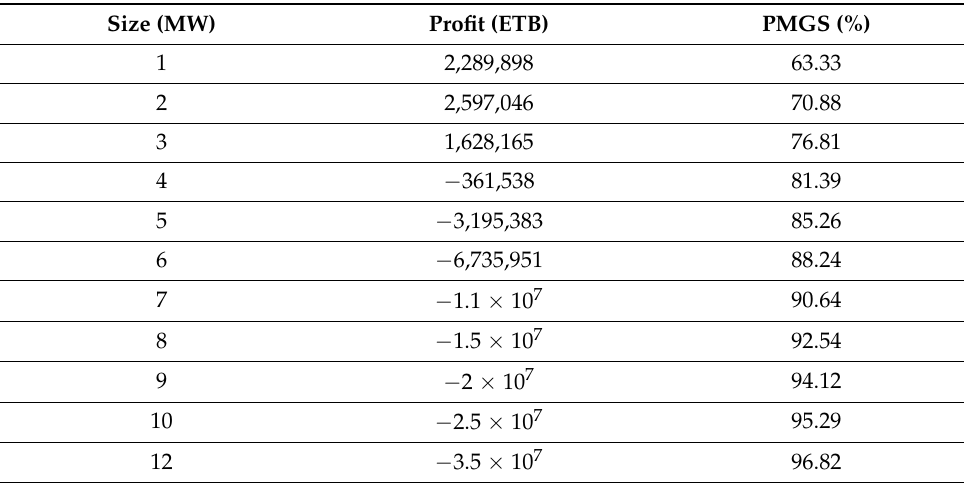
Table 5. Operation profits (OPB) and probabilities of meeting the generation schedule. Size (MW) Profit